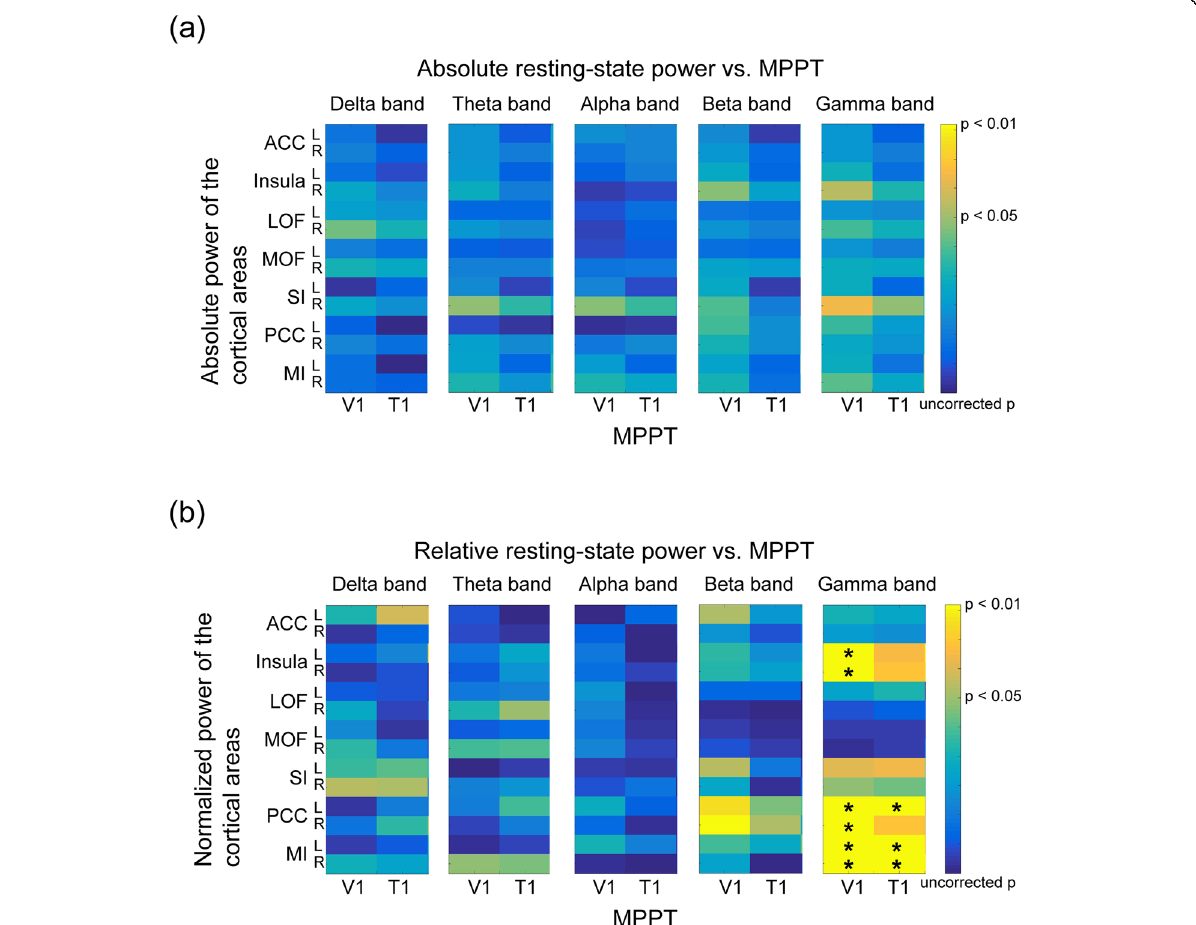
Fig. 2 Relationship of the mechanical punctate pain threshold with the ( a ) absolute power and ( b ) relative power at the delta to gamma bands in the pain-related regions in healthy individuals. The P -value of the correlation analysis is color-coded, with a significant value denoted with yellow. * P < .05 with false discovery rate correction. MPPT, mechanical punctate pain threshold; ACC, anterior cingulate cortex; LOF, lateral orbitofrontal cortex; MOF, medial orbitofrontal cortex; SI, primary somatosensory cortex; PCC, posterior cingulate cortex; MI, primary motor cortex; V1, left supraorbital (the first branch of the trigeminal nerve dermatome); T1, proximal medio-ventral forearm (the first thoracic nerve